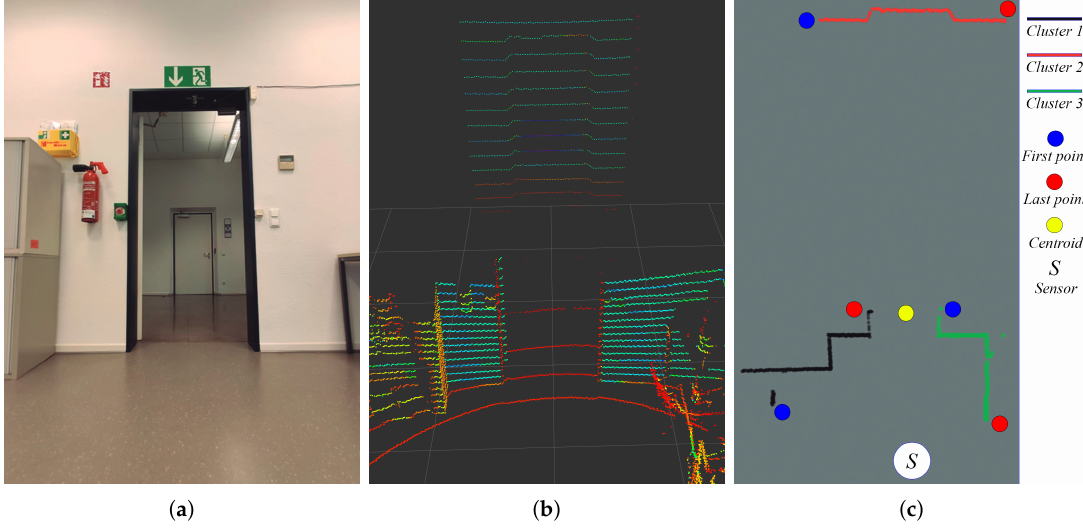
Figure 8. Depth segmentation: ( a ) real scenario; ( b ) sensed point-cloud; ( c ) top view of the point-cloud after merging heights, the three resulting clusters of the segmentation are